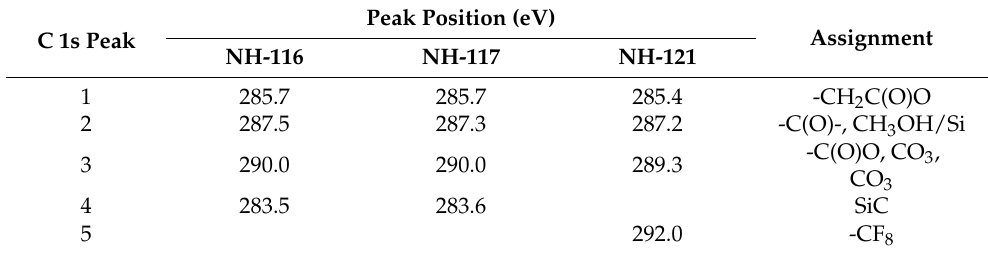
Table 4. The C 1s peak positions and their assignment for the different species found in the samples. C 1s Peak